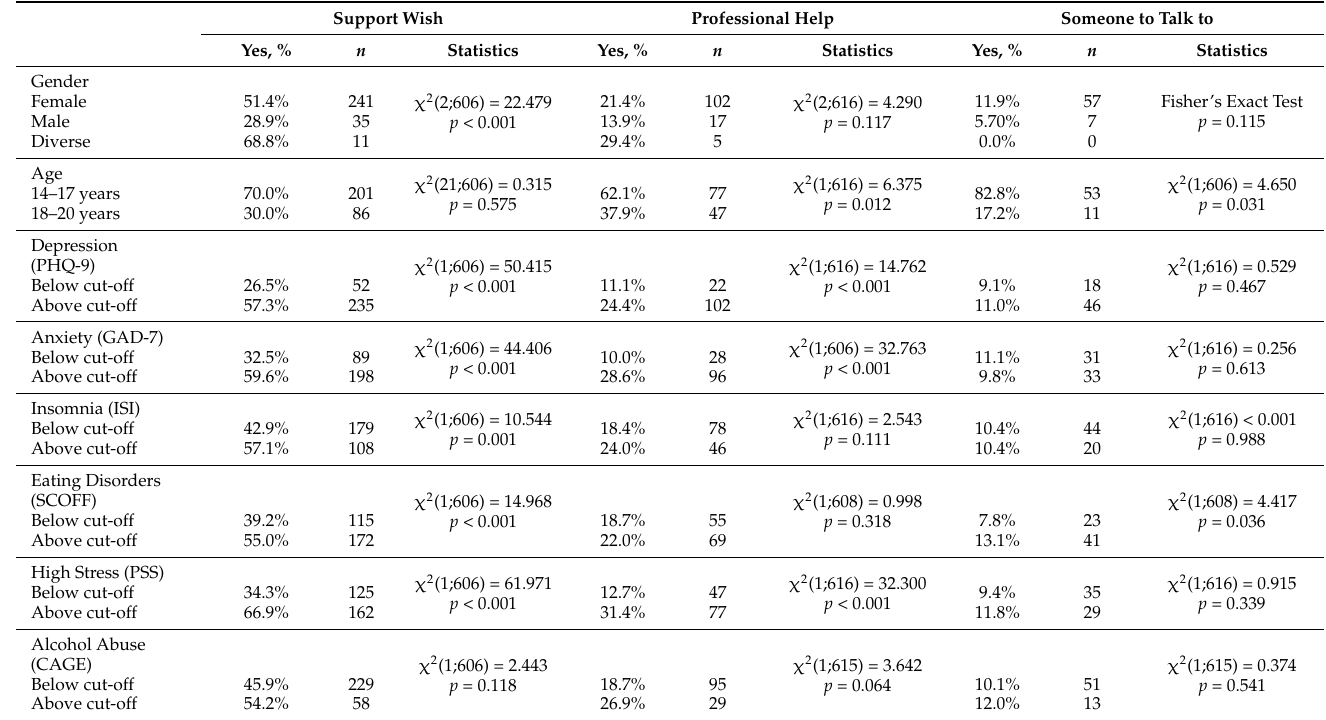
Table 3. Wish for support, professional help, and someone to talk to by gender, age group, and mental health